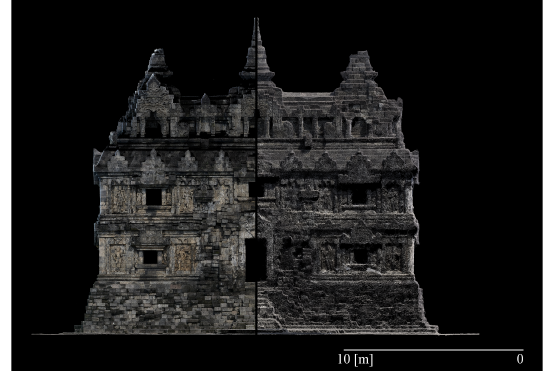
Figure 4. Orthoview of the Candi Sari point cloud from both laser scanning (left) and image matching of drone images (right) 3.5 Point cloud analysis